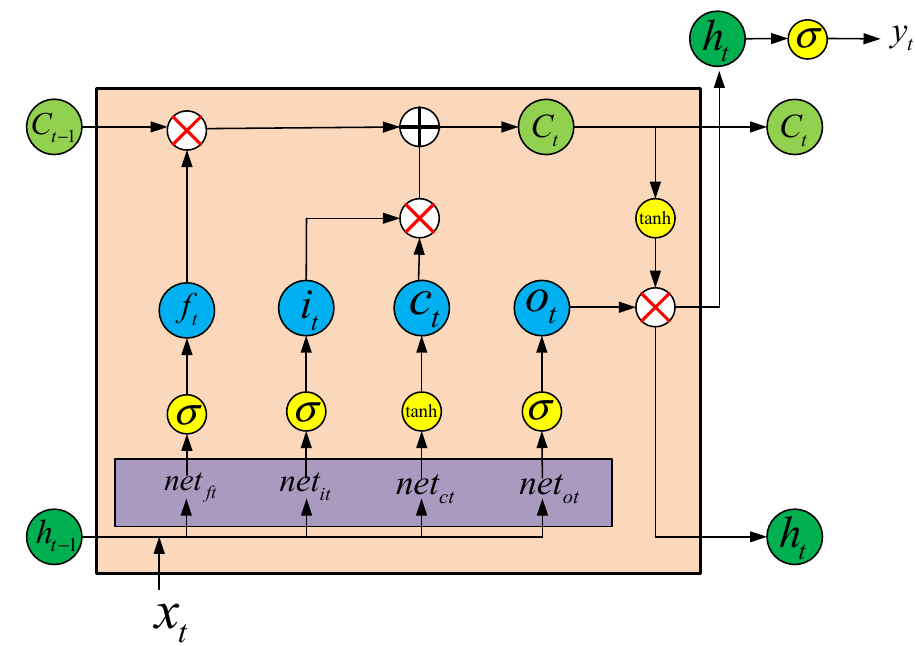
Figure 1. Schematic diagram of LSTM gate control structure. In the RNN network, the hidden layer has only one state, h , and a cell state, c , is added to the LSTM. Compared with the original RNN network, the LSTM is expanded according to the timeline, and the inputs are increased to three, including the cell state c t − 1 at the previous time, the output h t − 1 at the previous time, and the input x t at the current network. The outputs are increased to two, namely, the output h t of the LSTM at the current time and the cell state c t at the current